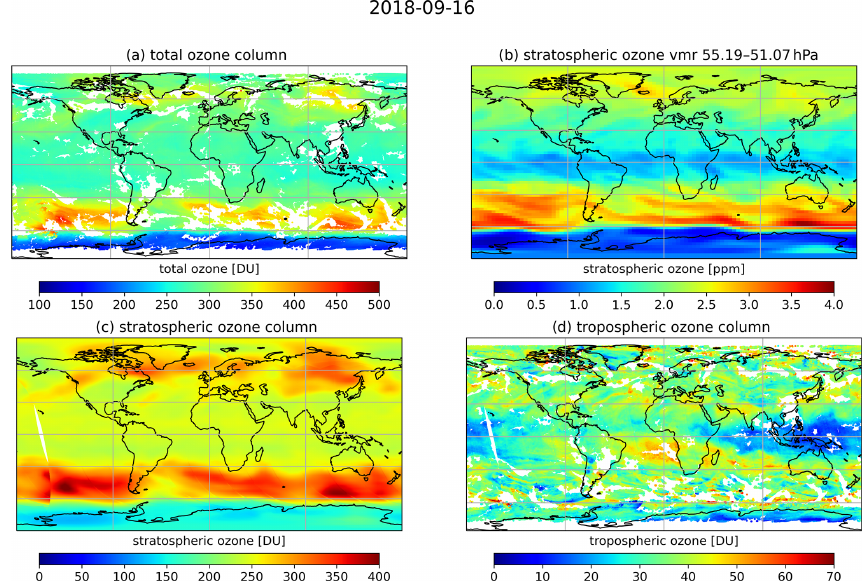
Figure 1. Overview of the tropospheric ozone retrieval. (a) TROPOMI NRTI total ozone column, where white regions represent cloud- screened data or no data availability. (b) BASCOE O 3 mixing ratio for 16 September 2018 at 12:00 UTC around 52hPa, with a resolution of 2.5 ◦ by 3.75 ◦ . (c) Integrated stratospheric ozone column from BASCOE interpolated in space and time to the TROPOMI observation; the data have the full S5P resolution, i.e. 7 × 3 . 5km 2 . At 170 ◦ W, the first and the last orbit of this day overlap, and thus the time difference of ≈ 23h between these observations causes a jump in the stratospheric ozone columns. (d) Tropospheric ozone column calculated as the difference between the total (a) and stratospheric column (c)